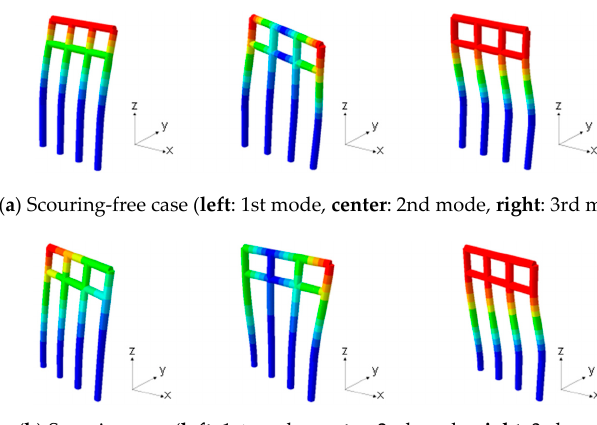
Figure 9. Mode shapes for the pier model.